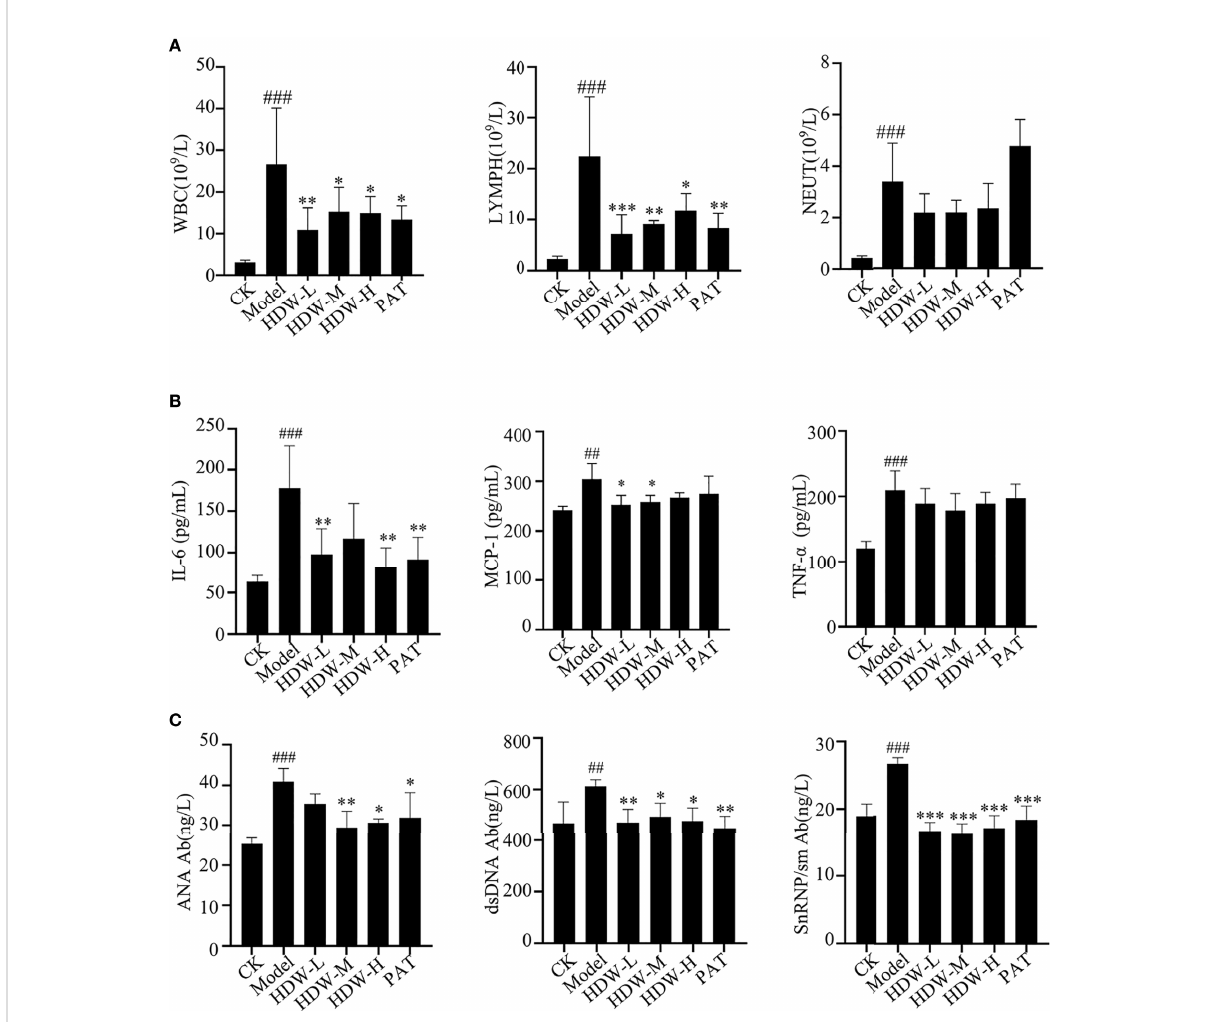
FIGURE 3 Effect of HDW on hematologic-related indices in MRL/lpr mice. (A – C) The effect of HDW on white blood cell parameters (A) , Serum Cytokine Pro fi les (B) , and the autoantibodies (C) of MRL/lpr mice. Six mice per group were included in the statistics. #Indicates the difference between the model group and the control group, ## P < 0.01, ### P < 0.001; * Indicates the difference between the treatment group and the model group * P < 0.05, ** P < 0.01, *** P <